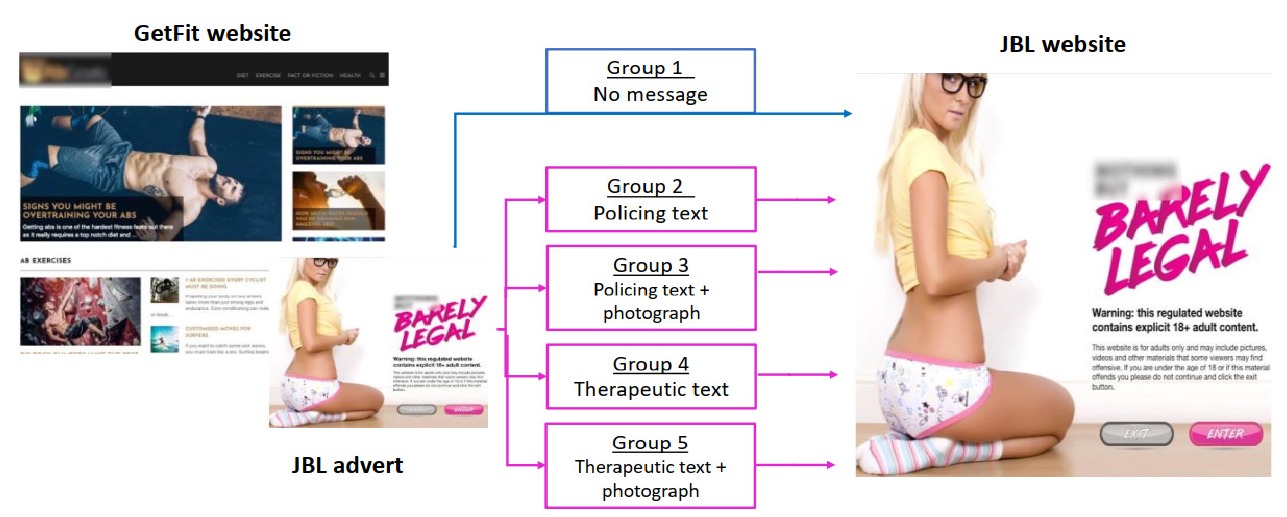
Figure 2. Screenshots of the benign website, GetFit, reached via an advertising campaign on social media and the honeypot ad and website, listing the experiment branches.